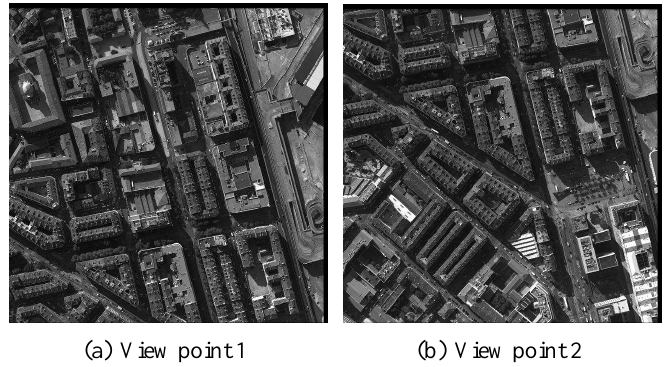
Figure 11. A pair sample of aerial images extracted of the multiscopic dataset. Each image covers a common area of the city of Marseille acquired from different points of view (partial overlapping). The size of the images is N correspond to the number of columns and rows,